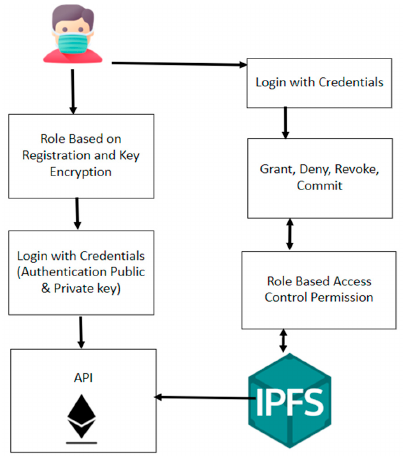
Figure 9. Assuring authorized users have access.